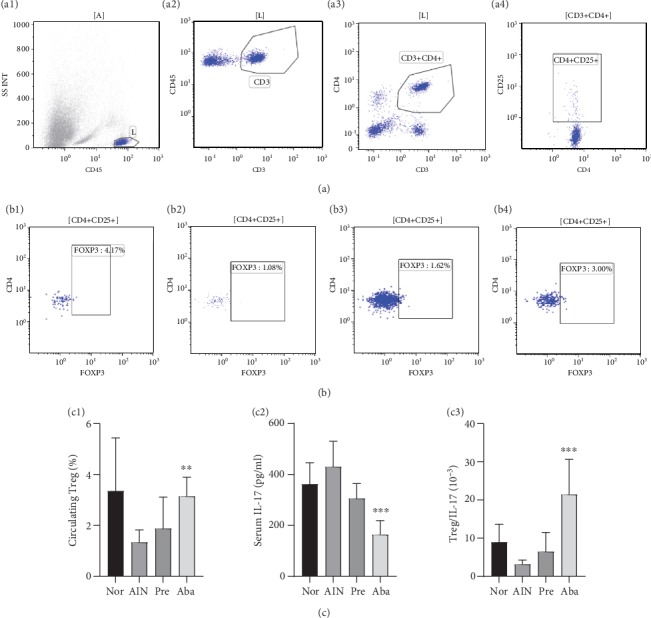
Abatacept regulated circulating Treg and IL-17 of AIN Rats. (a) CD3/CD45/SSC double-gating method was used for absolute count of CD3+CD45+FOXP3+ Treg cells. (b1) Treg of the normal group. (b2) Treg of the AIN group. (b3) Treg of the prednisone group. (b4) Treg of the abatacept group. (c1) Abatacept increased circulating Treg prevalence. ∗∗P < 0.01vs. the AIN group and P < 0.05vs. the Pre group. (c2) Abatacept decreased serum IL-17. ∗∗∗P < 0.001vs. the AIN group and Pre group. (c3) Abatacept regulated Treg/IL-17. ∗∗∗P < 0.001vs. the AIN group and Pre group. Nor: normal group; AIN: adriamycin-induced nephropathy group; Pre: prednisone group; Aba: abatacept group.